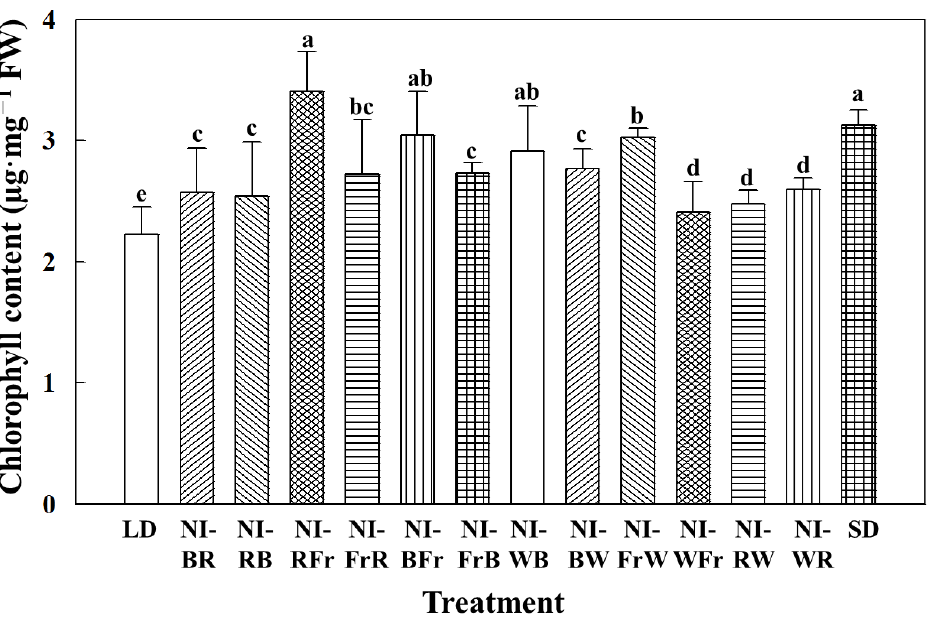
Figure 5. Effects of 10 µ mol · m − 2 · s − 1 PPFD night-interruption light (NIL) quality shifting on the chlorophyll content of geranium ( Pelargonium × hortorum L.H. Bailey ‘Ringo 2000 Violet’) leaves measured 40 days after treatment. Please refer to Figure 1 for detailed NIL qualities. Vertical bars are means ± S.E. (n = 3). Means accompanied by different letters are significantly different ( p < 0.05) according to Duncan’s multiple range test at 5% significance level. Table 2. Effects of 10 µ mol · m − 2 · s − 1 PPFD night-interruption light (NIL) quality shifting on the shoot/root fresh and dry weights of geranium ( Pelargonium × hortorum L.H. Bailey ‘Ringo 2000 Violet’) measured 40 days after treatment.